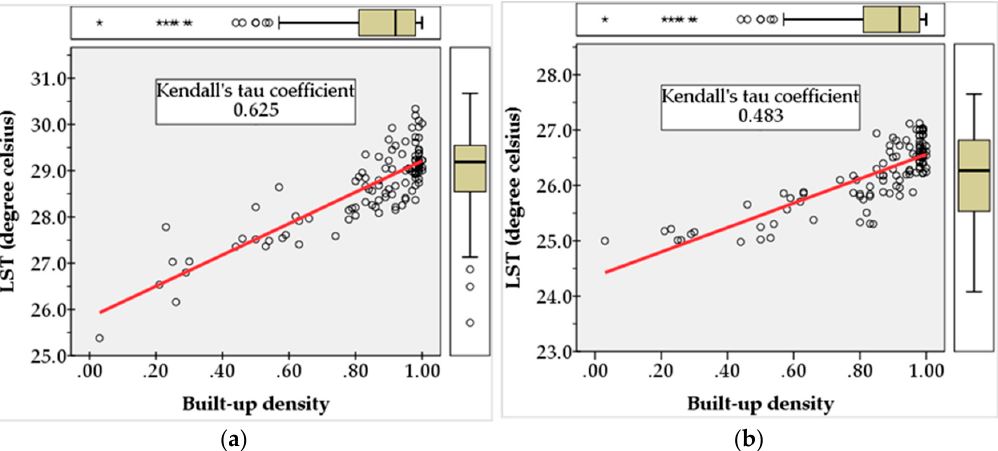
Figure 17. Relationship between (a) built-up density and summer land surface temperature (LST), (b) built-up density, and winter LST where the Y-axis shows LST in degree Celsius, the X-axis shows built-up density, and the red line is the slope of the correlation coefficient.